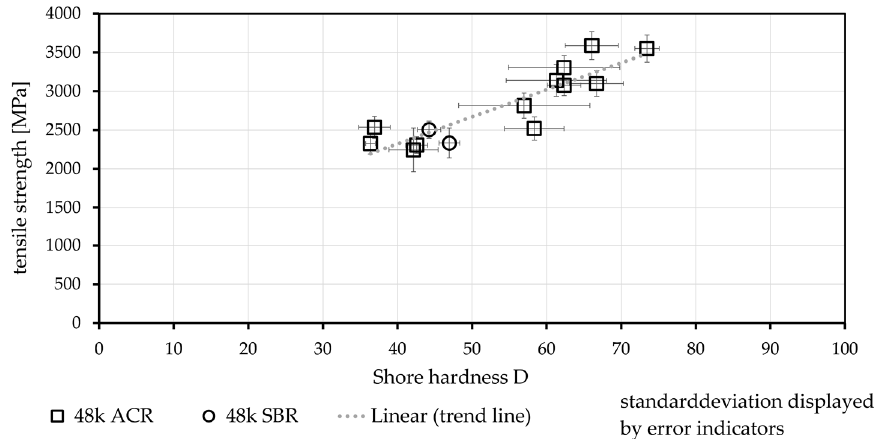
Figure 13. Correlation between Shore hardness and tensile strength of 48 k carbon textiles with varying impregnation agents (means values of 10–20).